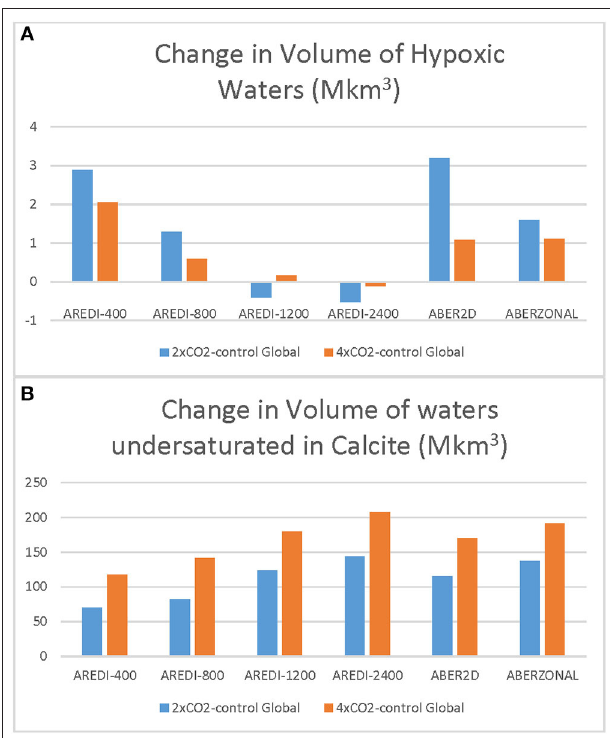
FIGURE 11 | Absolute changes in the volume of hypoxic waters (A) and waters undersaturated with respect to calcite (B) in Mkm 3 . Blue bars show response under 2xCO 2 . Gray bars show half of the response under 4xCO 2 -differences from blue bars show lack of